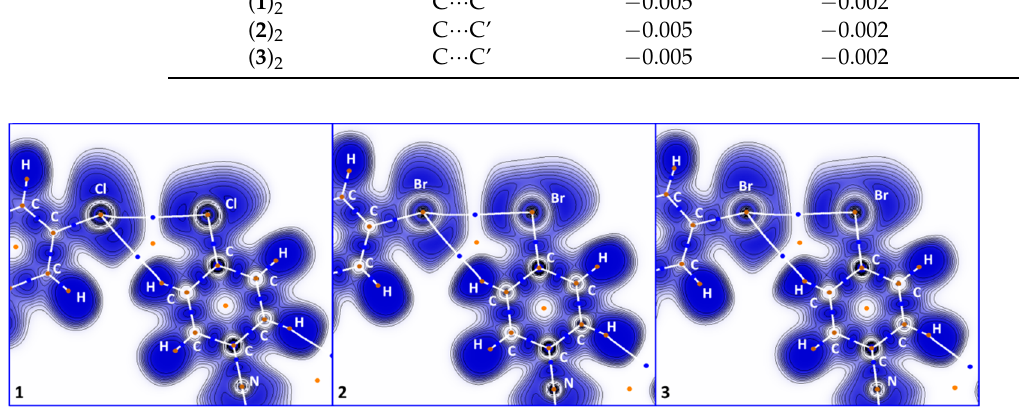
Figure 4. ELF projections and bond paths (white lines), BCPs (blue dots), nuclear critical points (brown dots), and ring critical points (orange dots) for the C–X ∙∙∙ X’–C and C–H ∙∙∙ X–C interactions in the ( 1 ) 2 (left), ( 2 ) 2 (middle), and ( 3 ) 2 (right) dimeric clusters of type I.